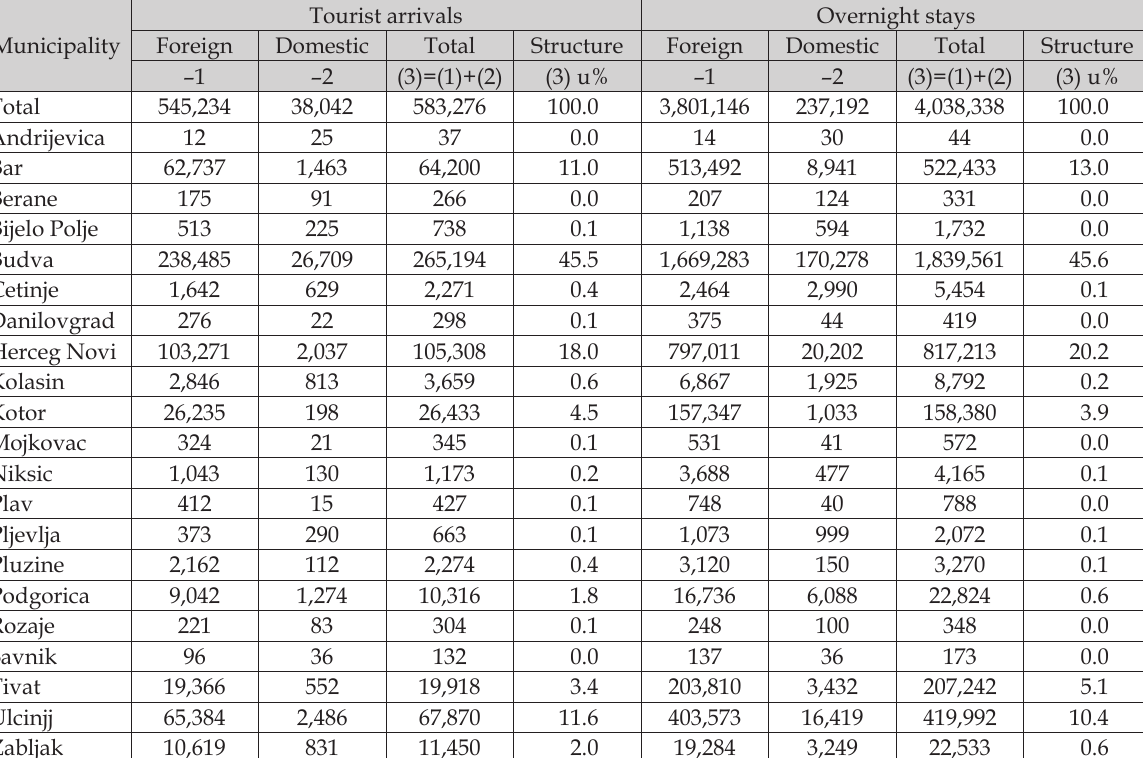
Table 1. Tourist arrivals and overnight stays by municipalities, Montenegro, August 2016 (Montstat 2016). Tourist arrivals overnight stays Municipality Foreign Domestic Total Structure Foreign